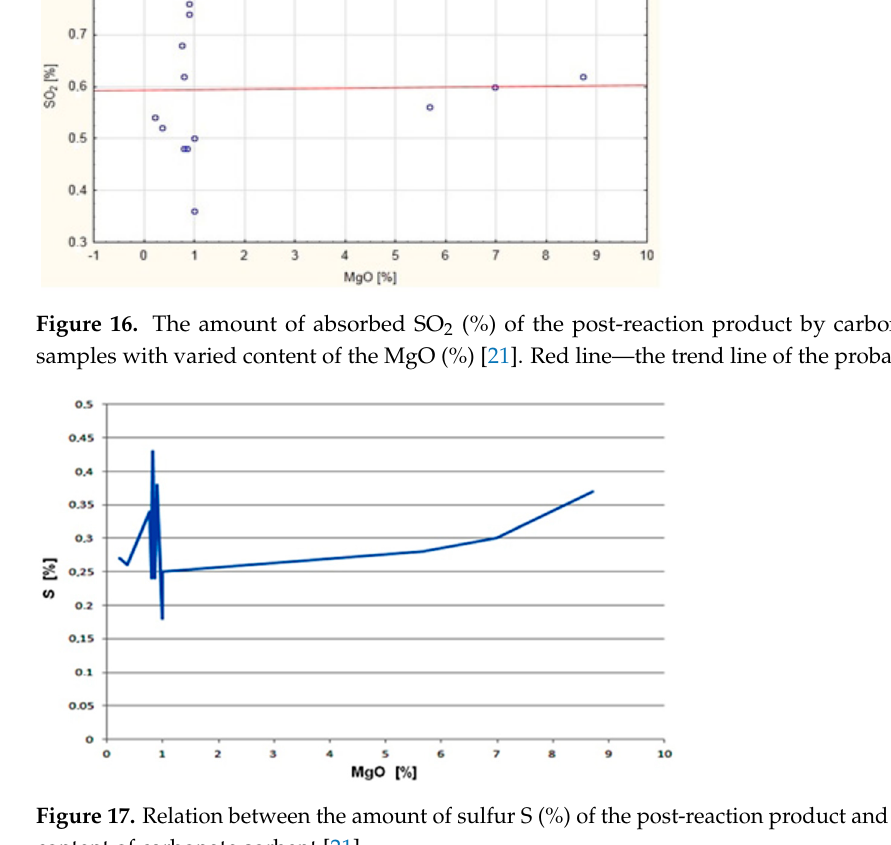
Figure 17. Relation between the amount of sulfur S (%) of the post-reaction product and the MgO (%) content of carbonate sorbent [21].